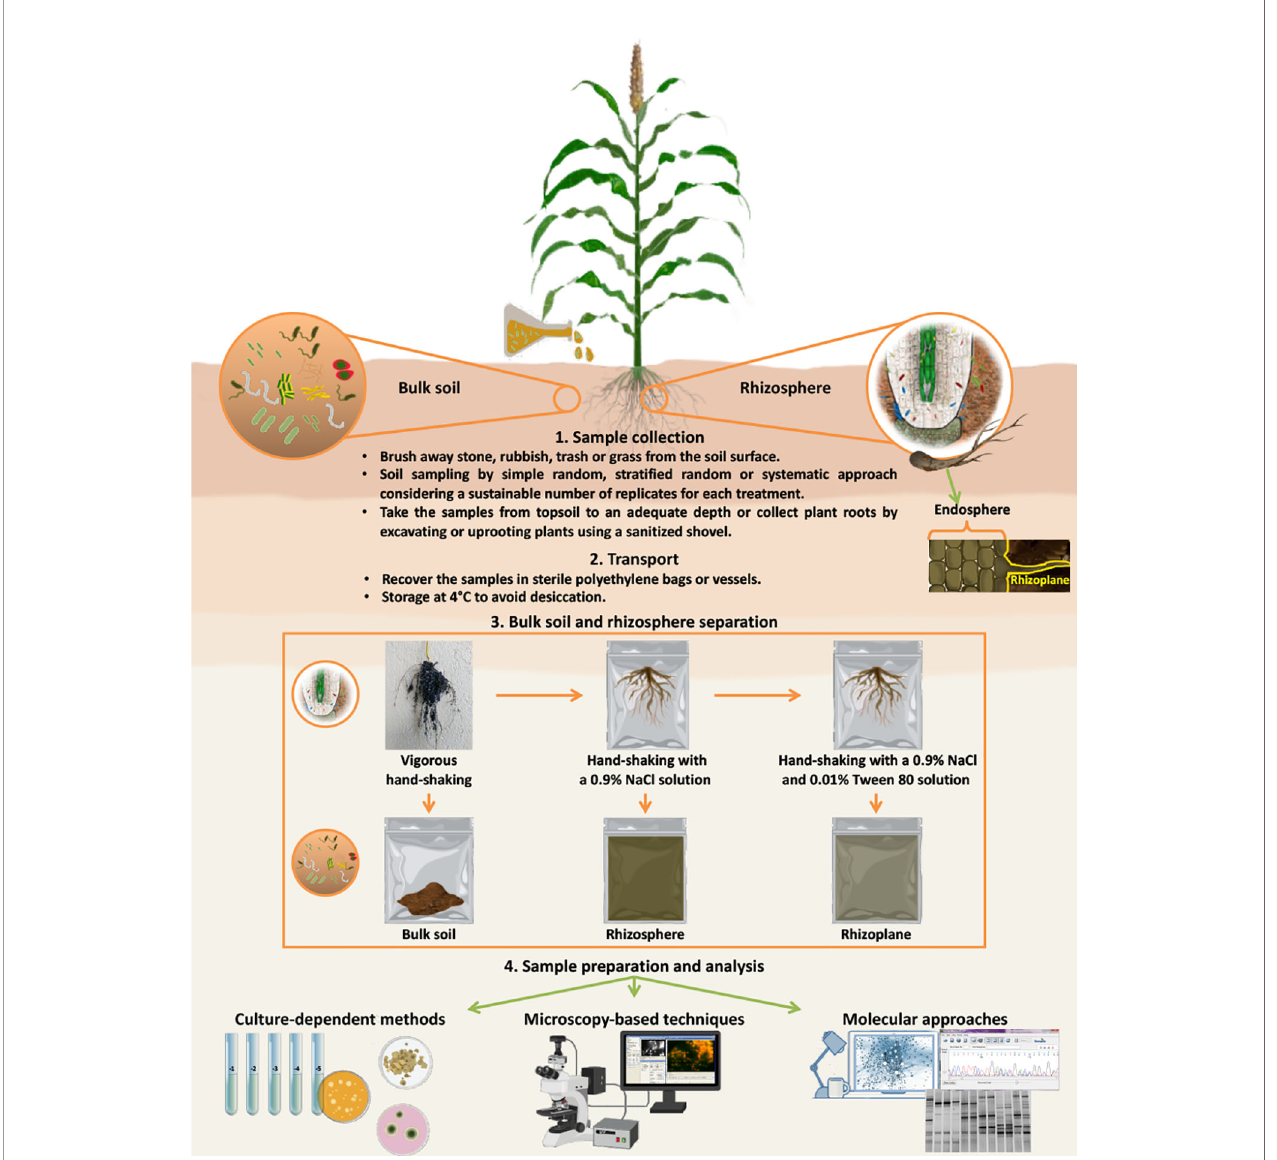
FIGURE 1 | Schematic description of sampling collection, separation of different soil fractions, and methods (culture-dependent methods, microscopy-based techniques and molecular approaches) for the detection of microbial inoculants. After plant sampling, roots should be shaken vigorously by hand to collect bulk soil (soil not adhering to roots and not in fl uenced by exudates). Shaking the roots a second time in a sterile 0.9% NaCl solution allowed rhizosphere (soil area in fl uenced by plant roots and their exudates) collection, and shaking the roots a third time in the same sterile solution containing Tween 80 (0.01% v/v) allowed the rhizoplane (thin layer of soil strongly adhering to the roots) fraction to be collected. To study microbial endophytes, it is necessary to add a step of sterilization of the root surfaces prior to grinding, chopping or blending them. Root samples should be analyzed in a short time (24 – 48 h) to evaluate the density of the cultivable microorganisms by plating on growth media or they can be stored in a solution PBS buffer and 70% ethanol at -20°C for later analysis by culture-independent methods (microscopic and molecular